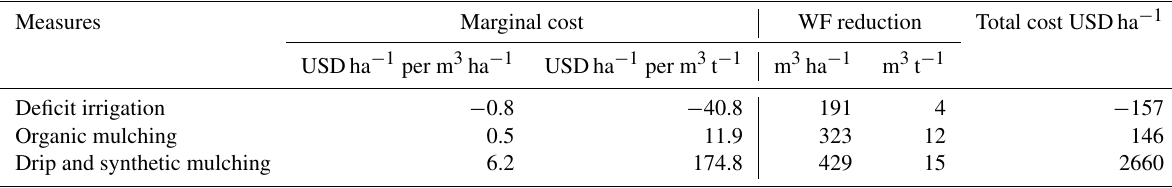
Table G5. Marginal cost and WF reduction per subsequent measure in the MCC for WF reduction in potato production for the baseline of furrow irrigation combined with full irrigation and no mulching.